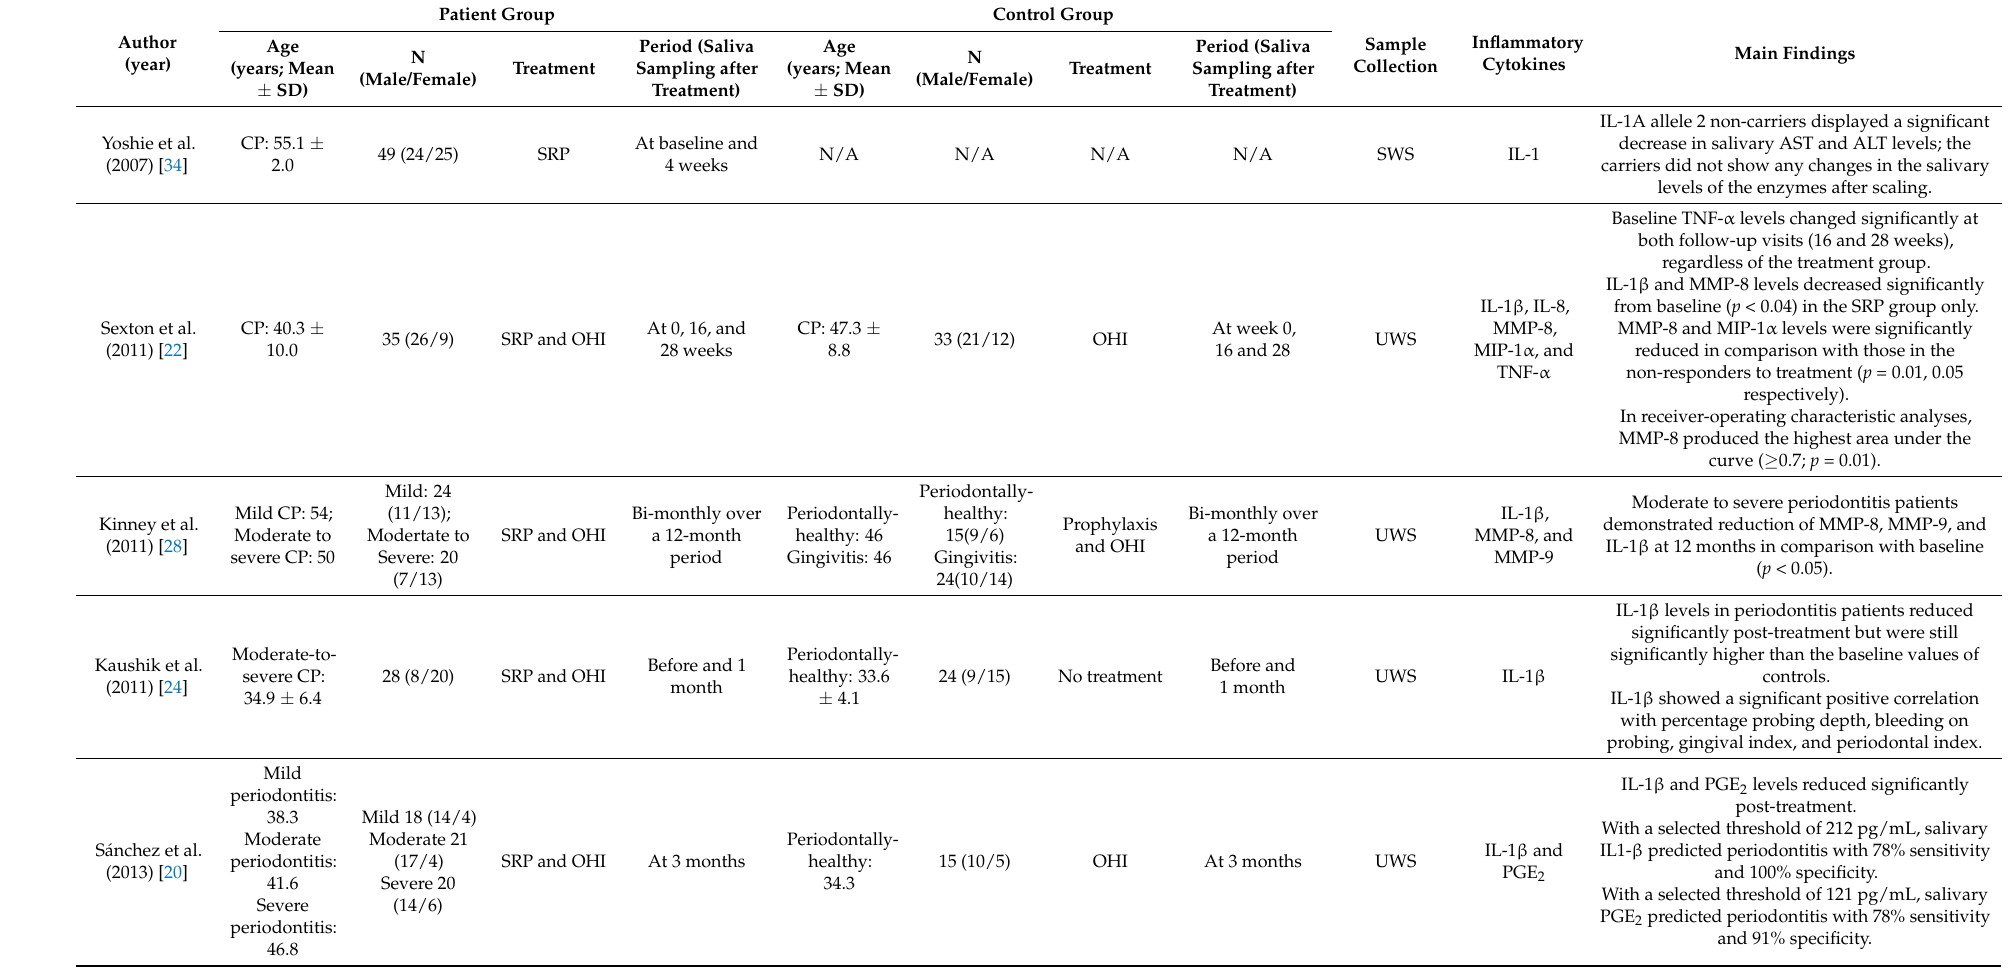
Table 2. Characteristics of the included